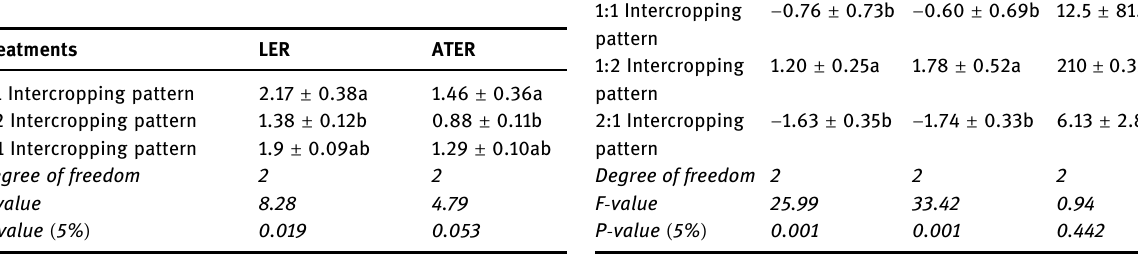
Table 3: LER and ATER of intercropping patterns